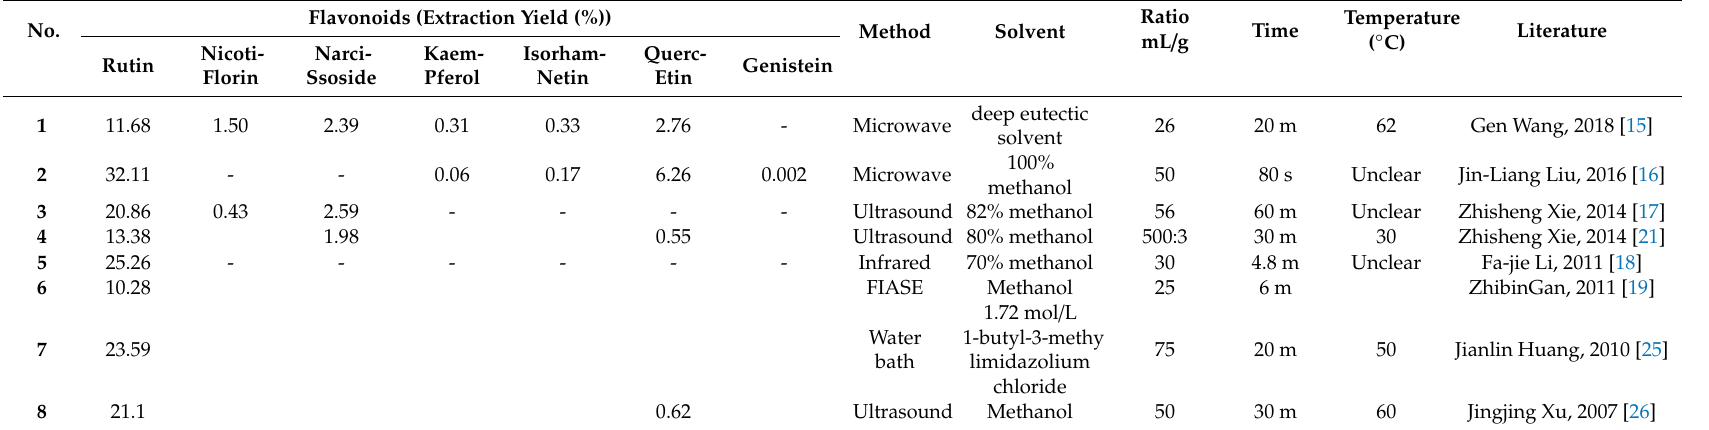
Table 1. Extraction conditions of di ff erent extraction methods in Flos Sophorae Immaturus